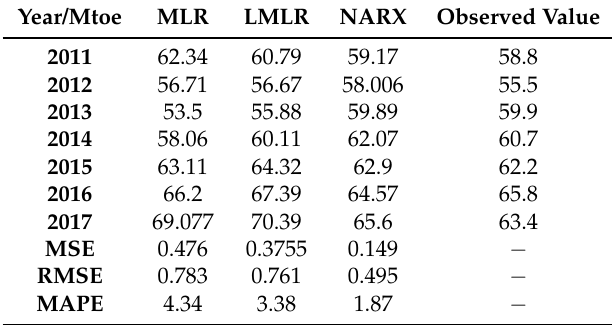
Table 4. Evaluation of RCEC prediction by MLR, LMLR and NARX.